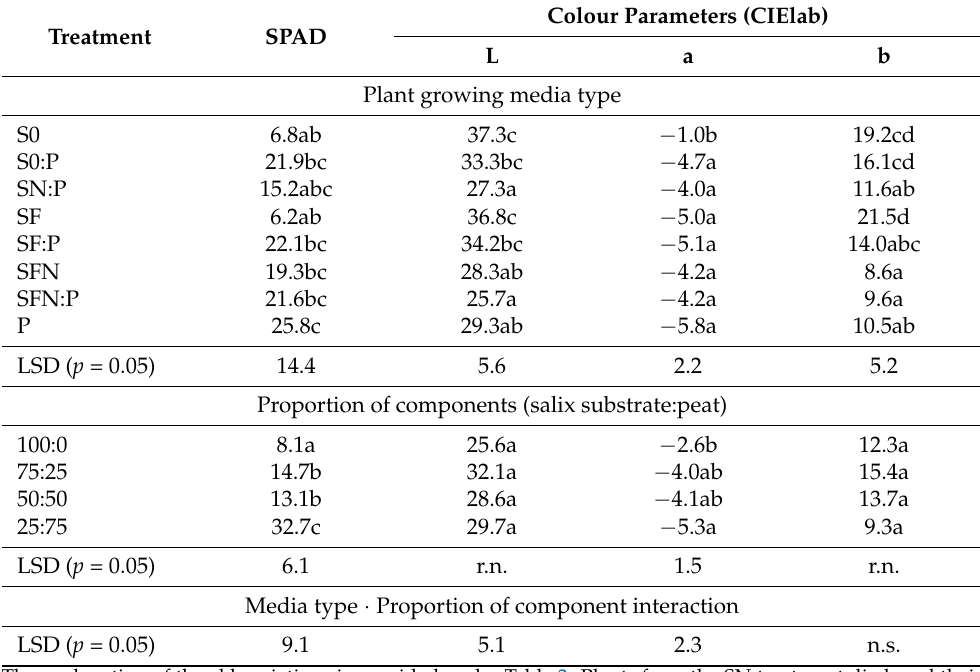
Table 6. The effect of horticulture media on the leaf greenness index (SPAD) and CIELab parameters. Colour Parameters (CIElab) Treatment SPAD L a b Plant growing media